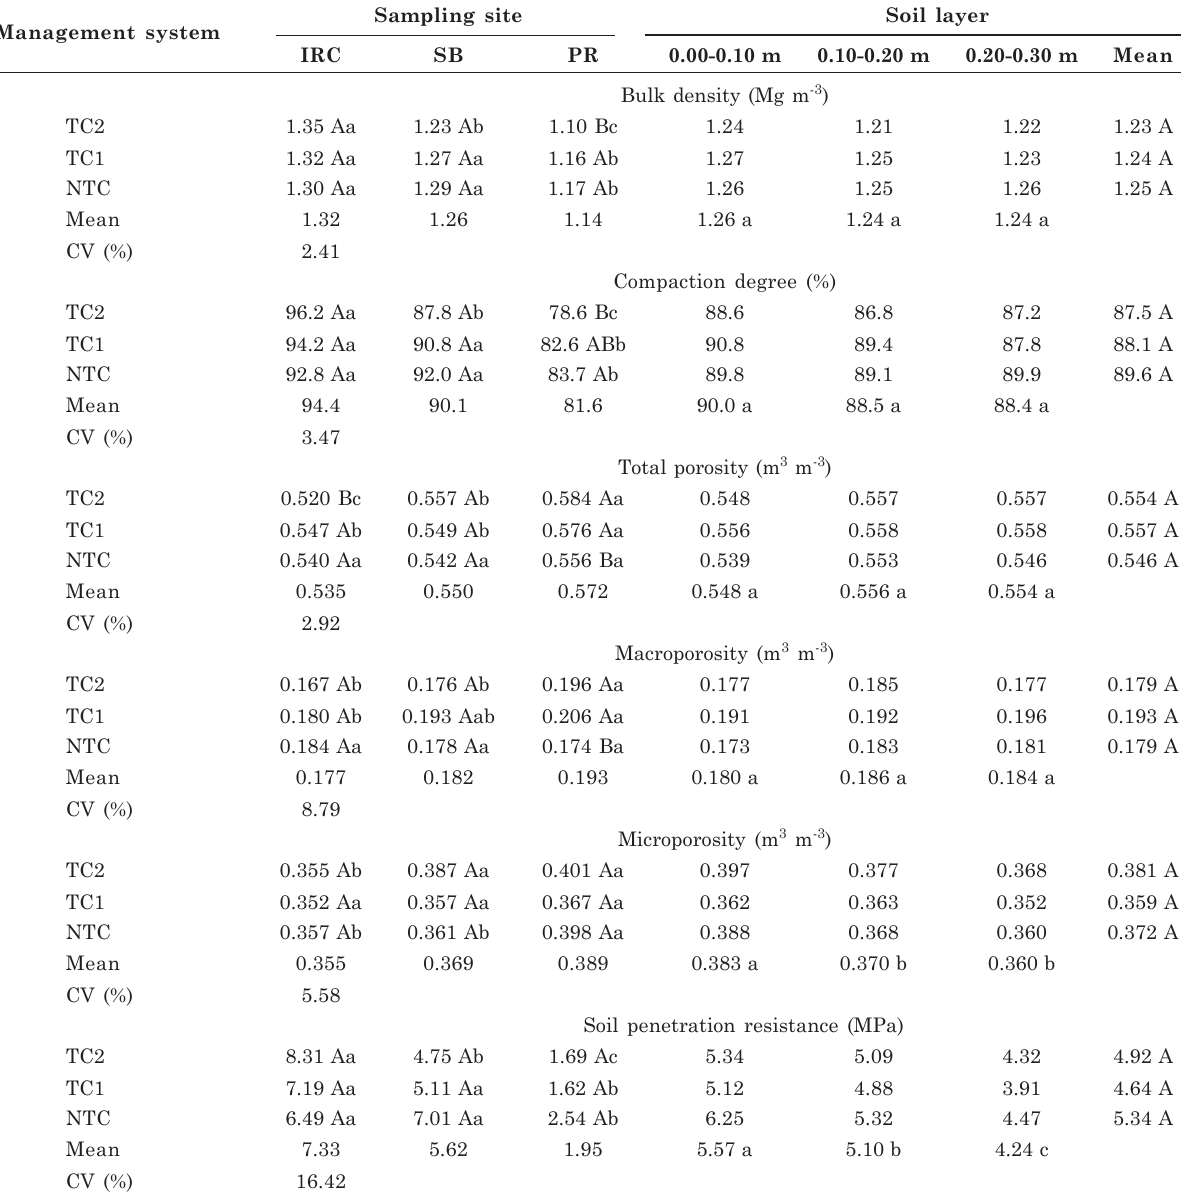
Table 2. Physical properties of an Oxisol measured in the plant row (PR), inter-row center (IRC) and seedbed (SB) in the studied layers under managements with traffic control consisting of the adjustment of the track width and use of an autopilot (TC2) and only adjusted track width (TC1) and no traffic control